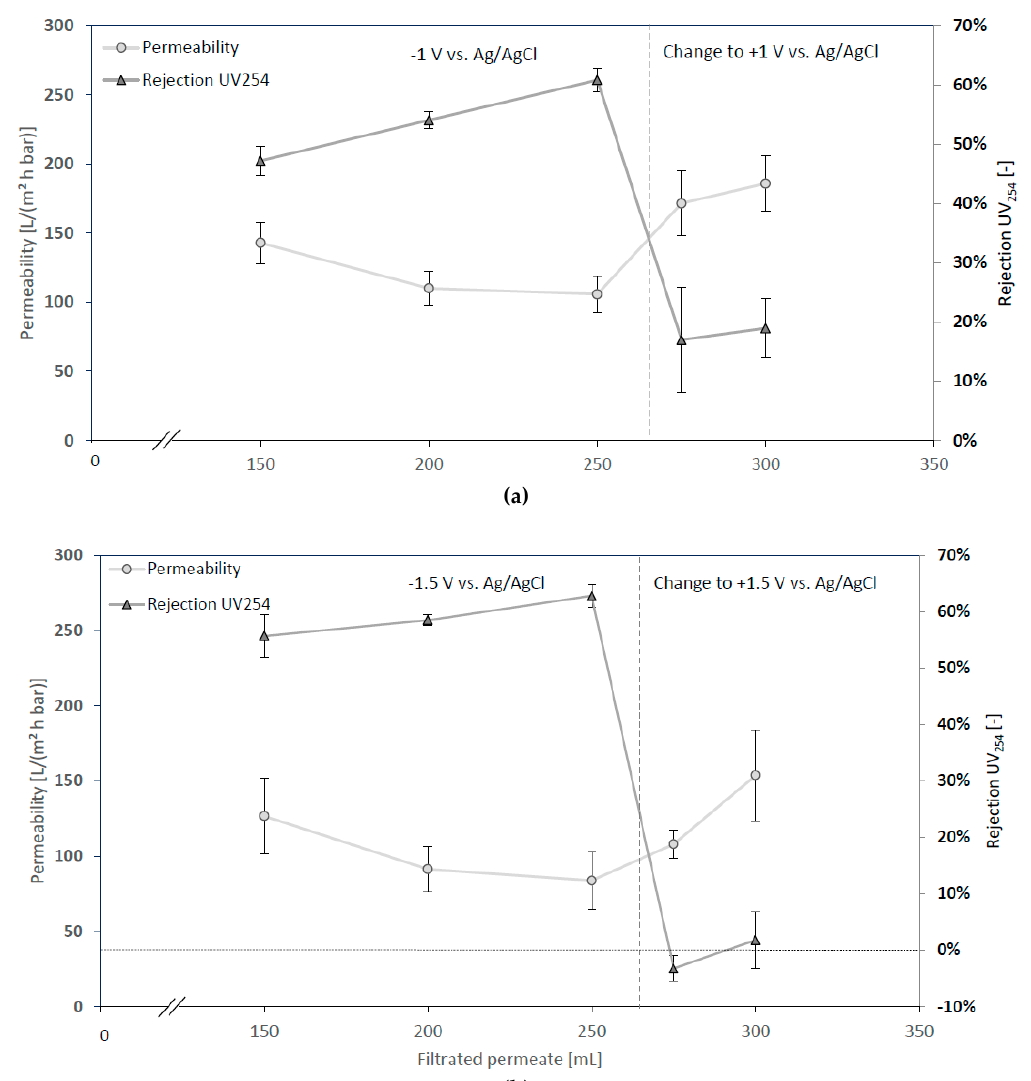
Figure 7. Filtration experiment with changing surface potentials; feed: 6 mg L − 1 of SRNOM, 1 mmol L − 1 NaCl, pH 7; ( a ) applied surface potential − 1 V changed to +1 V vs. Ag/AgCl after 250 mL filtration; ( b ) applied surface potential − 1.5 V changed to +1.5 V vs. Ag/AgCl after 250 mL filtration; error bars present standard deviations.